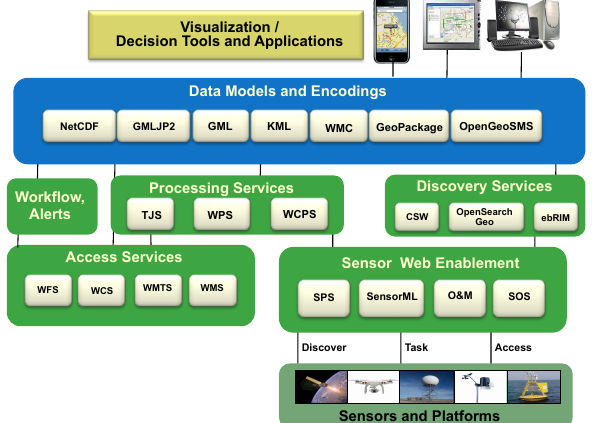
Figure 7. OGC Standards Relevant to